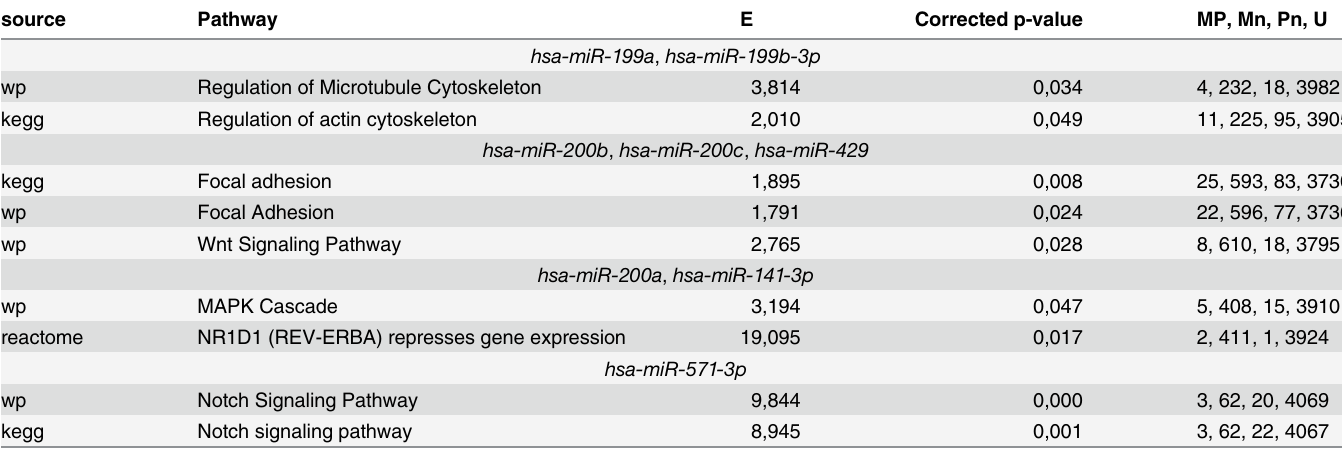
Table 1. Pathway enrichment used in the case studies with liver